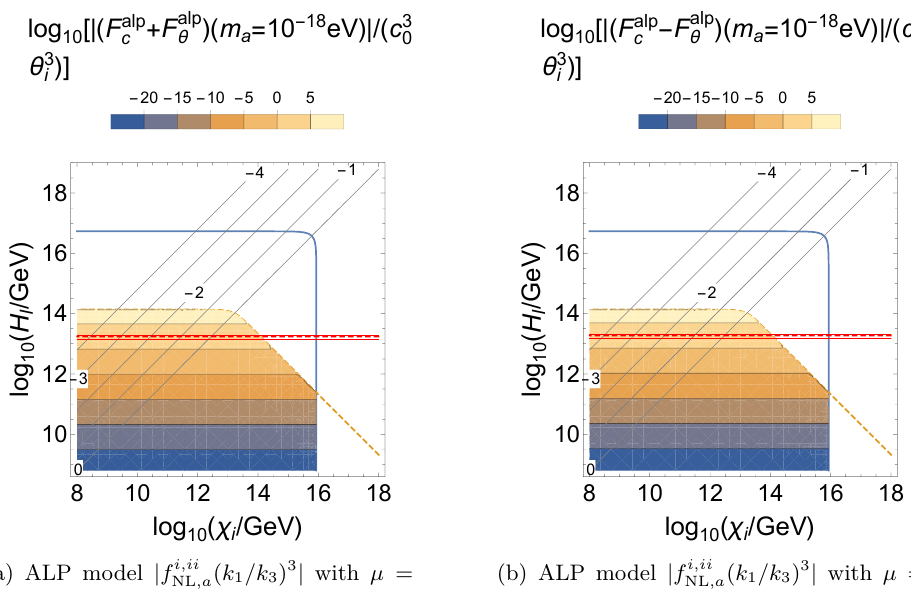
( k ) 3 | = 1 /k 3 NL ,a = − 290 ± 210 , if c is taken to be 0 θ i NL